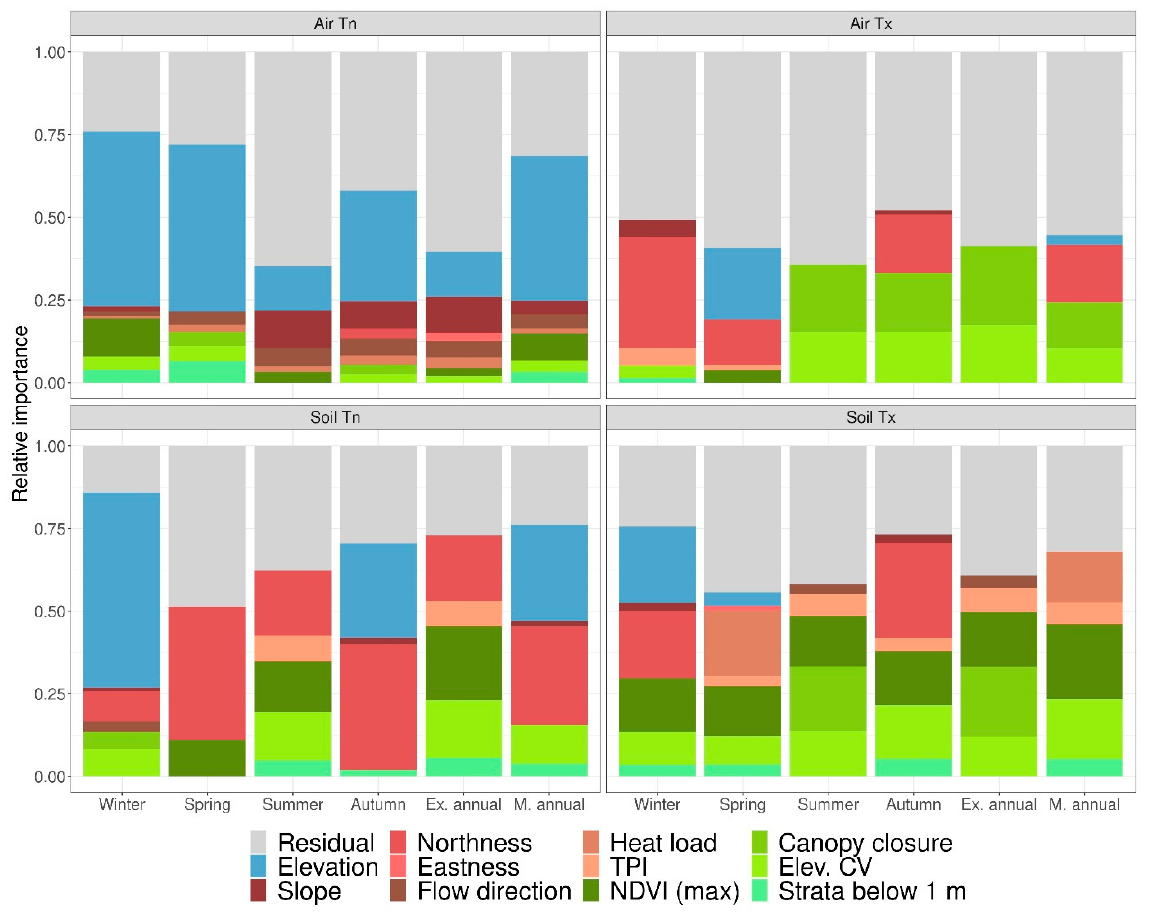
Figure 12. Relative importance of explanatory variables for modeling T offsets (T recorded by in situ sensors, T estimated by WorldClim) in the air and soil along 2100 m of the elevation of the PNOMP. The columns correspond to one of the six models: the four seasons, the annual extreme (Ex. annual), and the annual mean (M. annual).